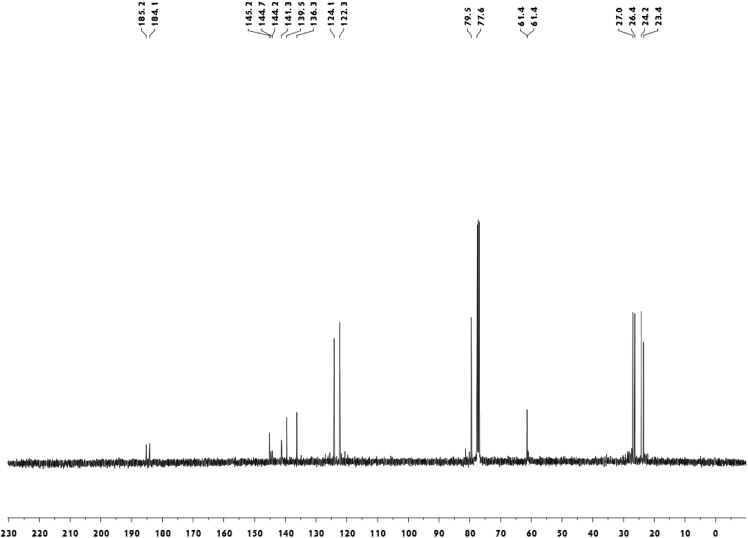
13C-NMR spectrum of meroterpenoid 5.